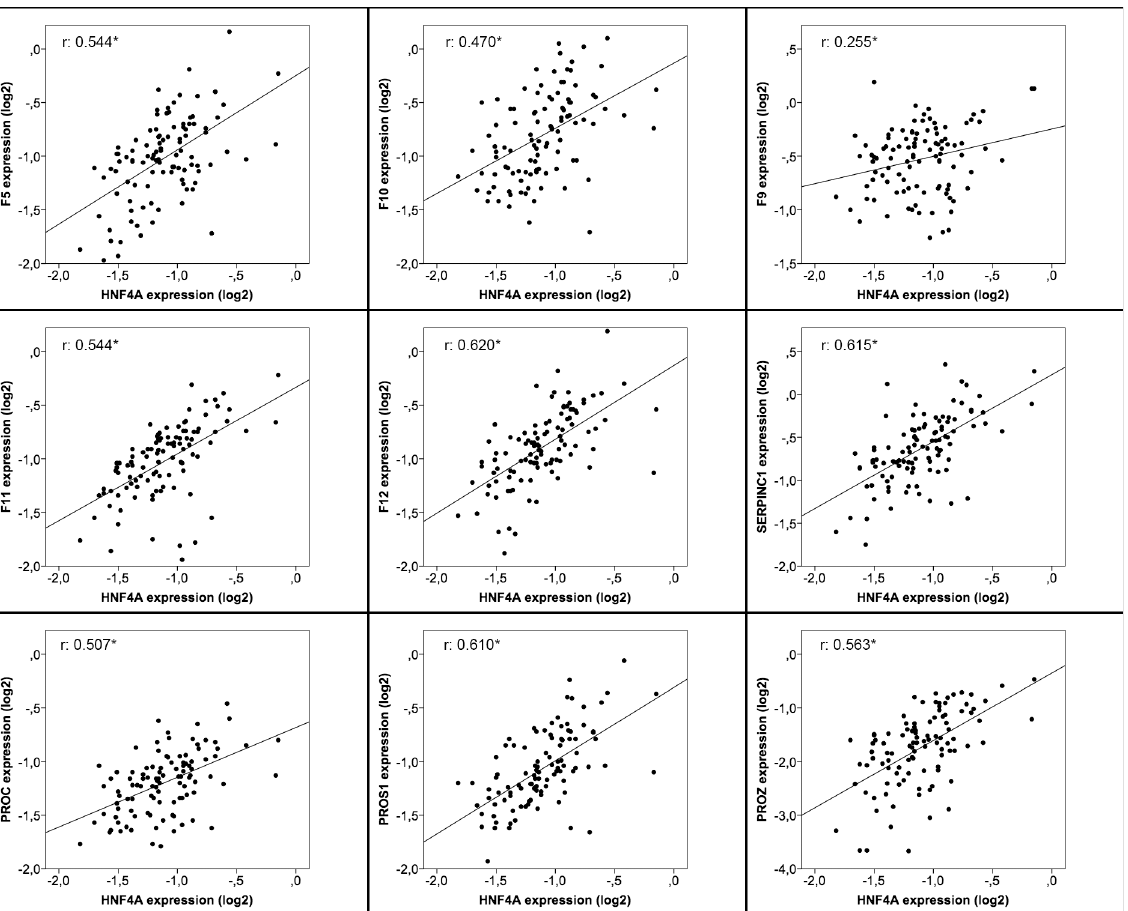
Fig 2. Correlation of mRNA expression levels of pro- and anti-coagulant factors with hepatic transcription factor HNF4A . Positive and significant correlations between procoagulant ( F5 , F9 , F10 , F11 , and F12 ), anticoagulant ( SERPINC1 , PROC , PROS1 , and PROZ ) factors and HNF4A mRNA expression. qRT-PCR was performed in total RNA purified from healthy livers (n = 104). Each data point represents an individual liver tissue sample, and a correlation coefficient (r) is shown. The results are presented as Log2 fold change with respect to the normalization standard. The asterisk indicates a statistically significant difference (p <